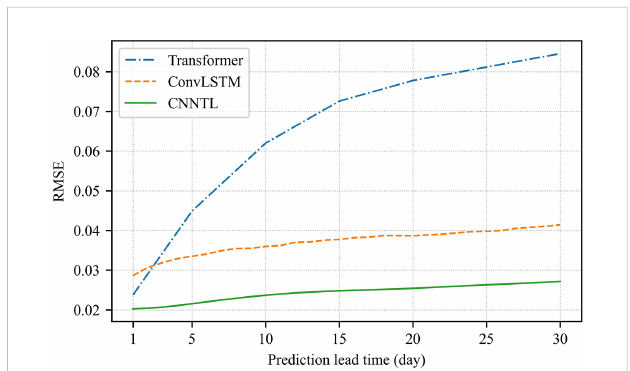
FIGURE 12 The root mean square error (RMSE, unit: m) of SSHA. The CNNTL model was compared with a transformer model (blue dot dash line), a convolutional long short term memory networks (ConvLSTM) model (orange dashed line), and CNNTL (green solid